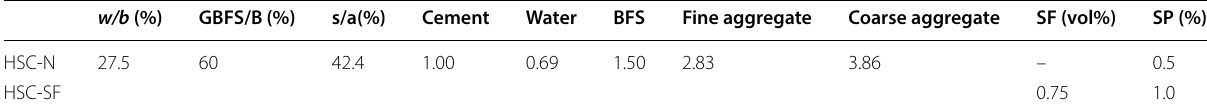
Table 1 Proportion of materials in the HSC